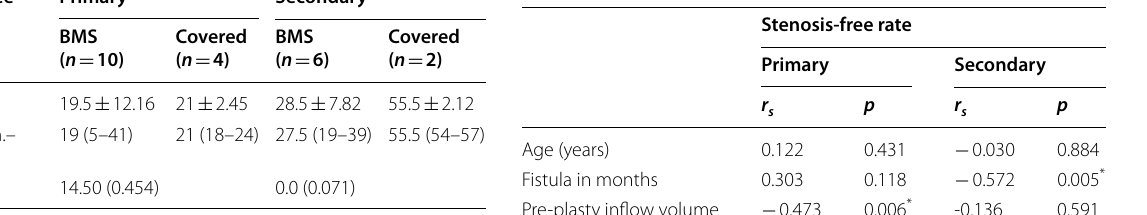
Table 6 Correlation between patient’s age, age of fistula, and pre-plasty inflow volume with primary and secondary